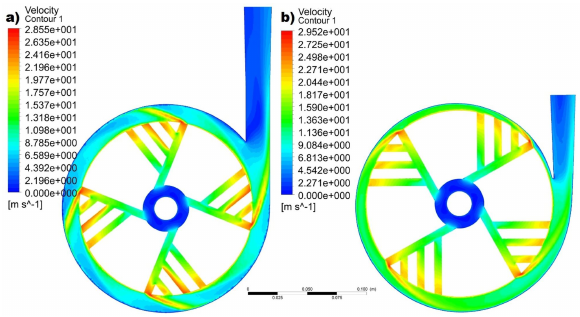
Figure 21: Distribution of liquid velocity on the model central plane (a) base annular casing VB and (b) final volute casing